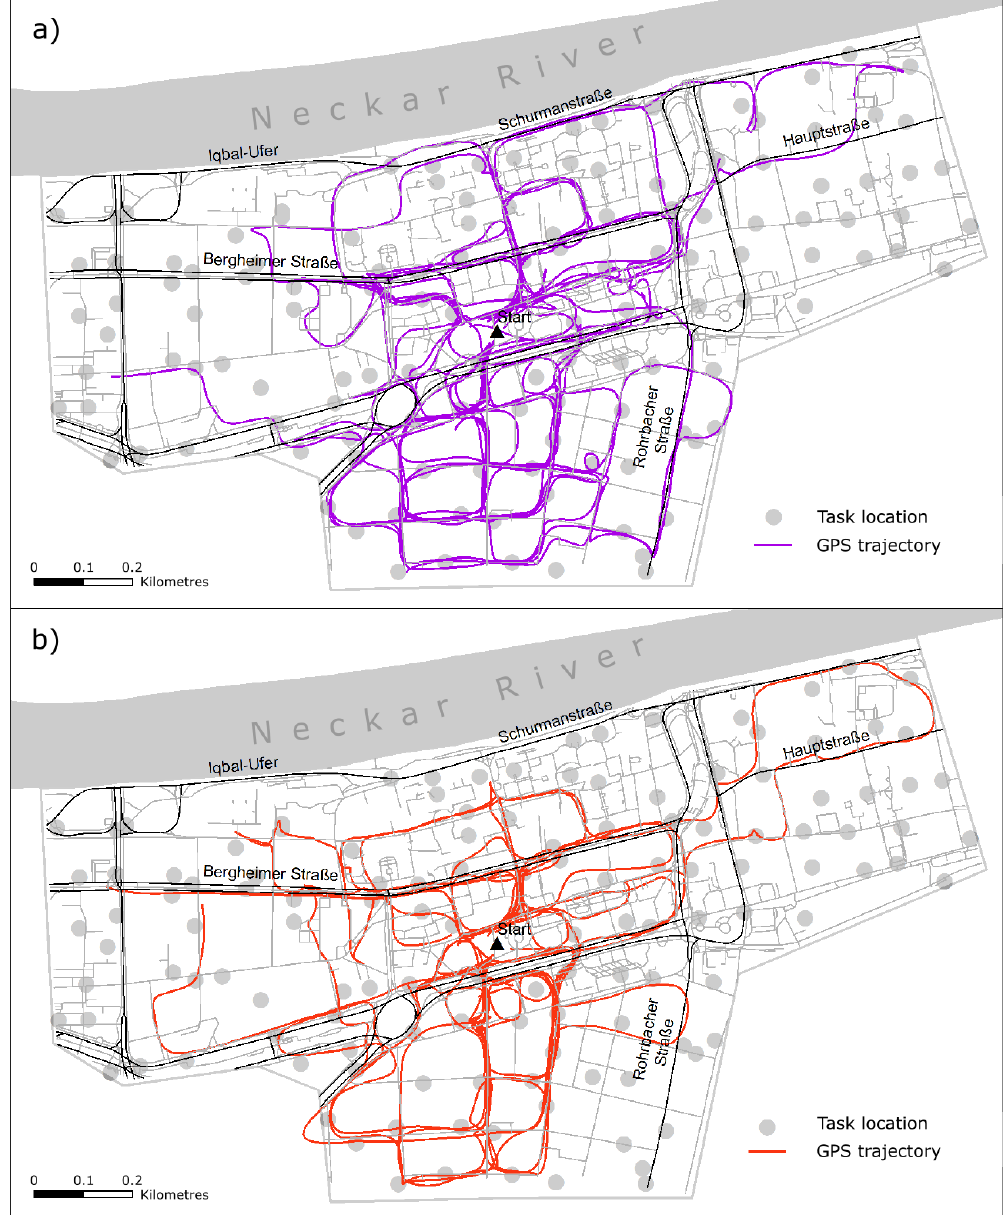
Figure 7. Overview of the GPS trajectories of all players. The line segments of the tracks were smoothed for display using the Polynomial Approximation with Exponential Kernel (PAEK) method [99]. ( a ) Spatially random setup; ( b ) and spatially structured